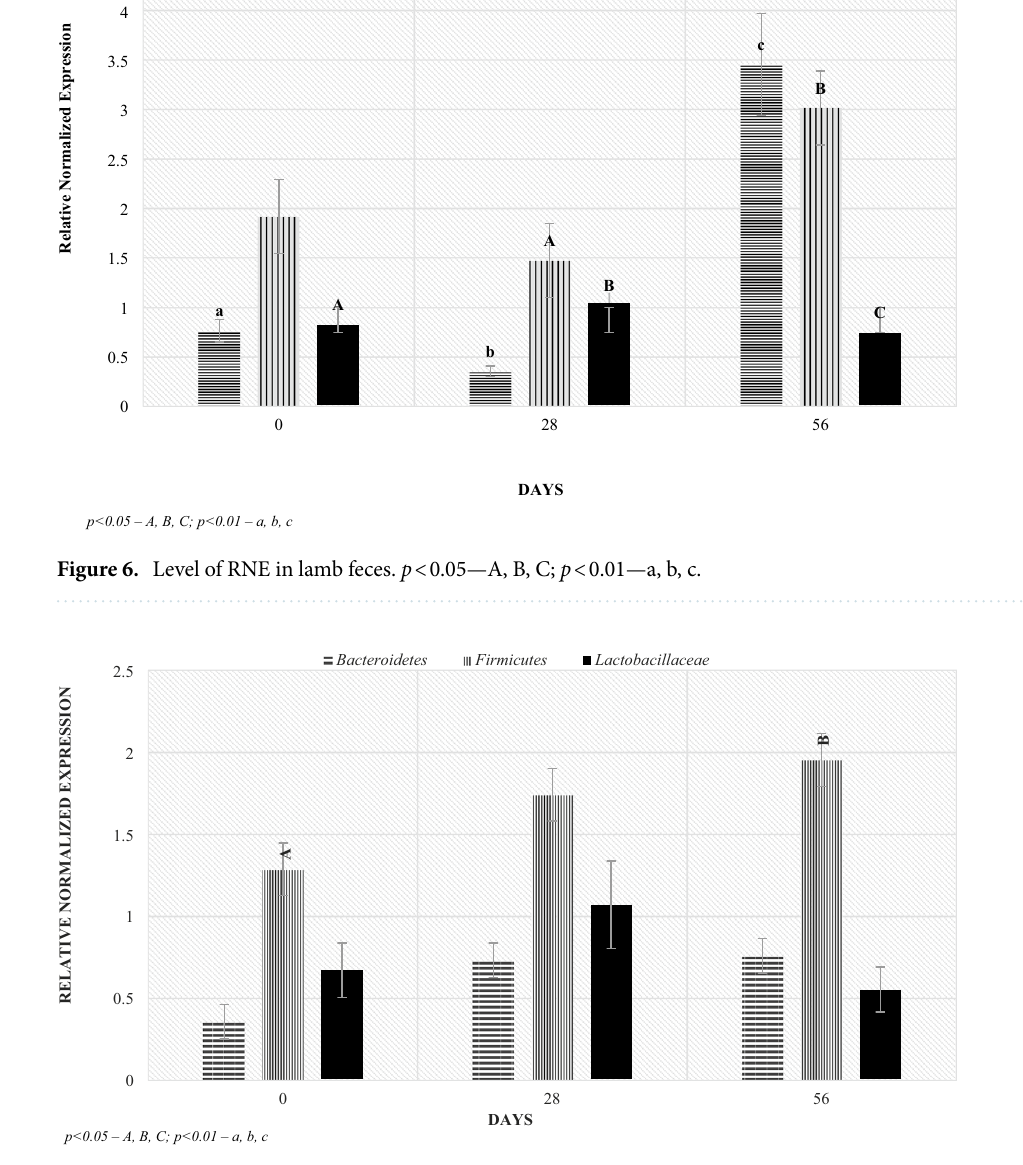
Figure 7. Level of RNE in ewes feces. p < 0.05—A, B, C; p < 0.01—a, b,